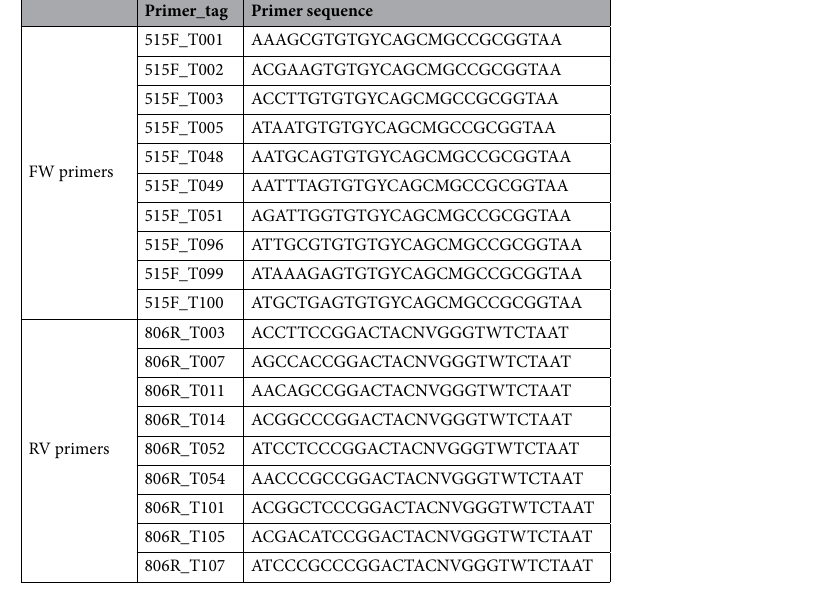
Table 1. List of primers used in the present